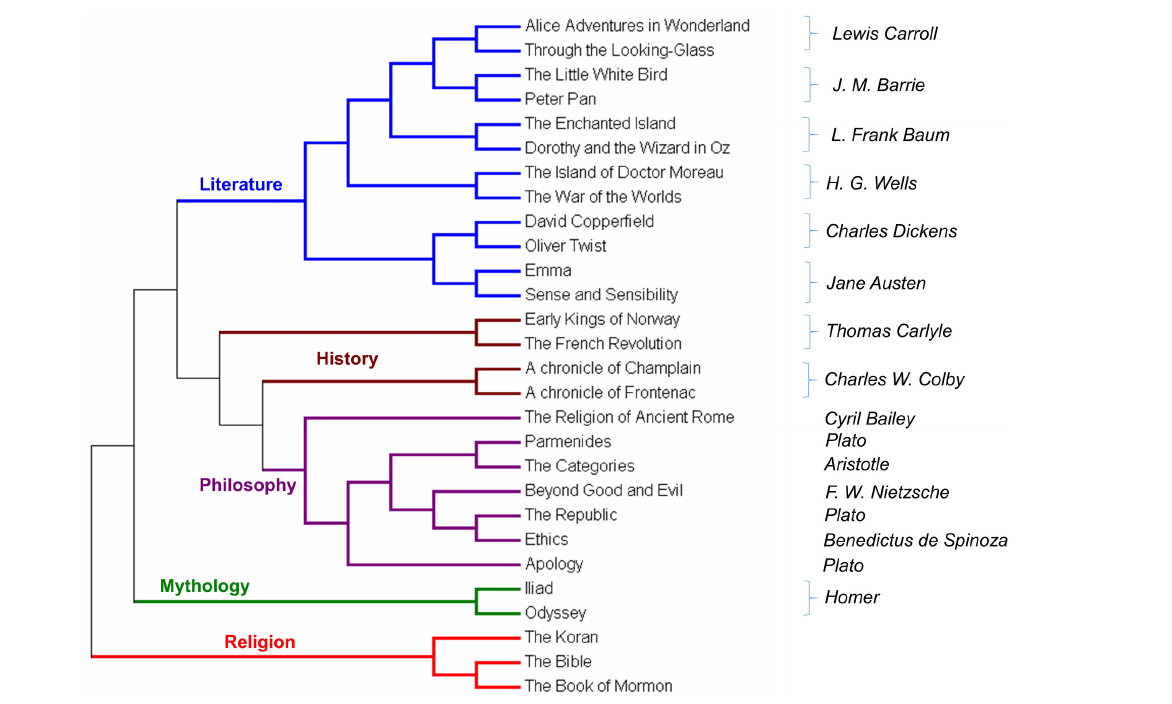
FIGURE 3 | Text comparison with MEF